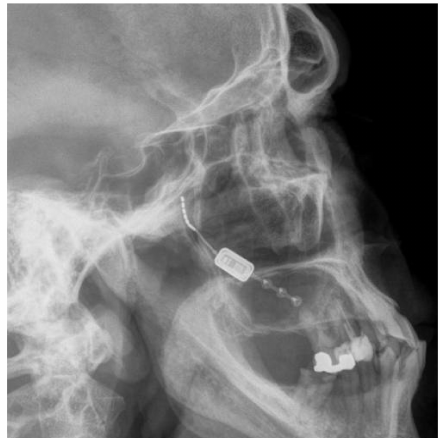
Figure 2. An illustration showing the trajectory of the implant introducer device used to place the ATI-Neurostimulator at the location of the sphenopalatine ganglion in the pterygopalatine fossa from an intra-oral incision at the posterior superior vestibule of the maxilla.